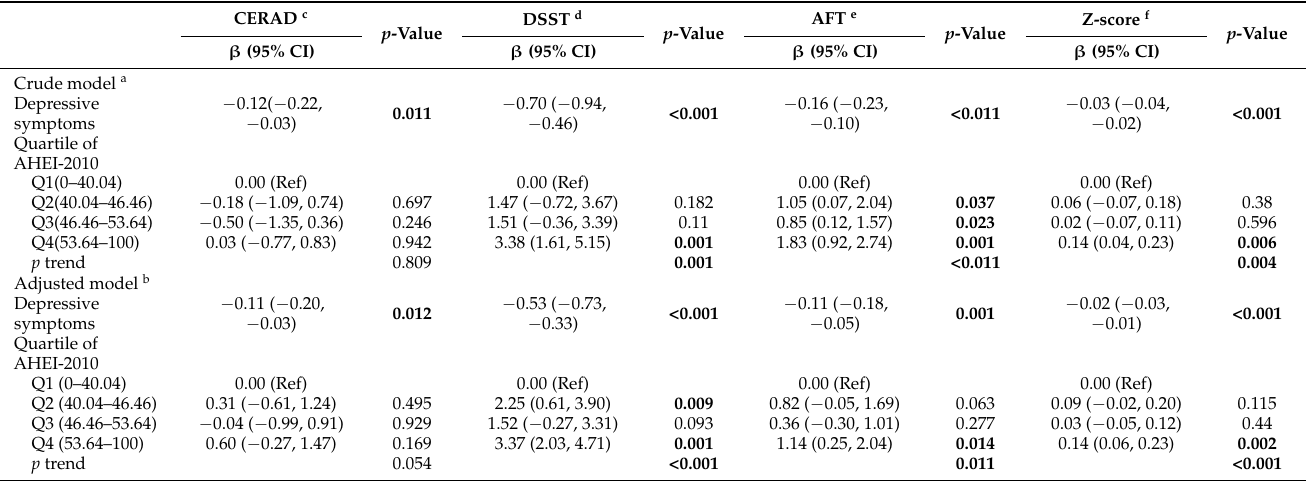
Table 2. Associations of quartile of AHEI-2010 and depressive symptoms with cognitive function: NHANES: 2011–2014.